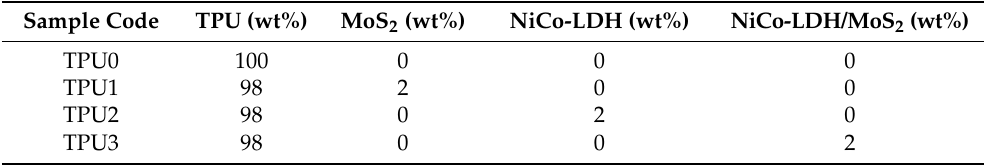
Table 1. TPU composites formula table.